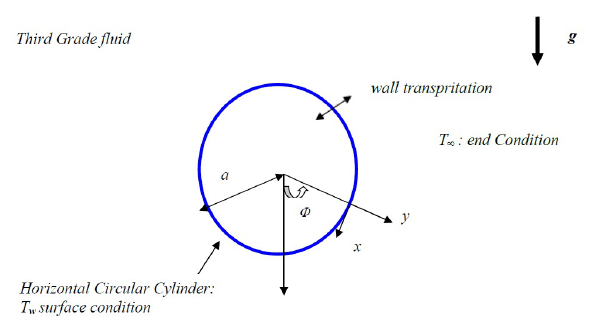
Fig. 1: Physical model and coordinate